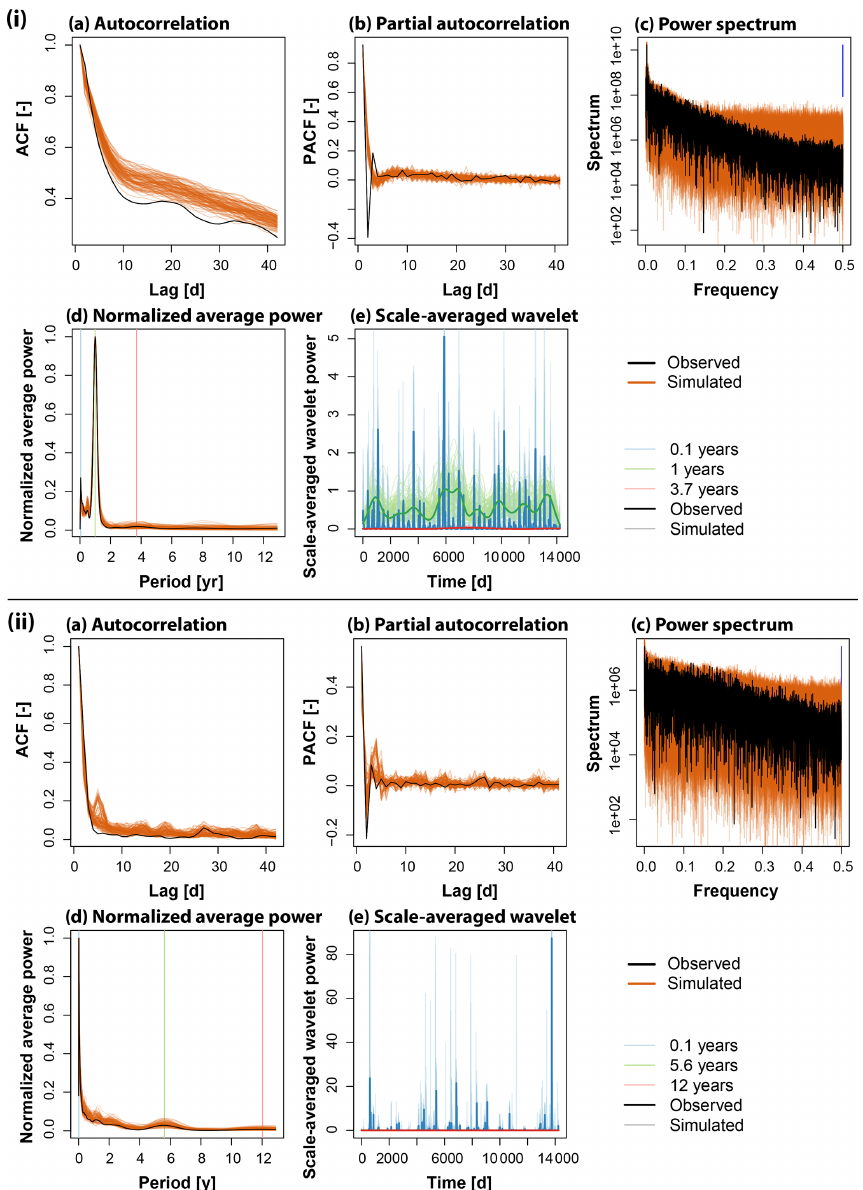
Figure 4. Comparison of observed (black) and simulated (orange) temporal discharge characteristics for (i) the station Nehalem River near Foss, OR (USGS 14301000, id 661) in the Pacific Northwest and (ii) the station Navidad River near Hallettsville, TX (USGS 08164300, id 464): (a) acf, (b) pacf, (c) power spectrum, (d) normalized average power, and (e) scale averaged-wavelet